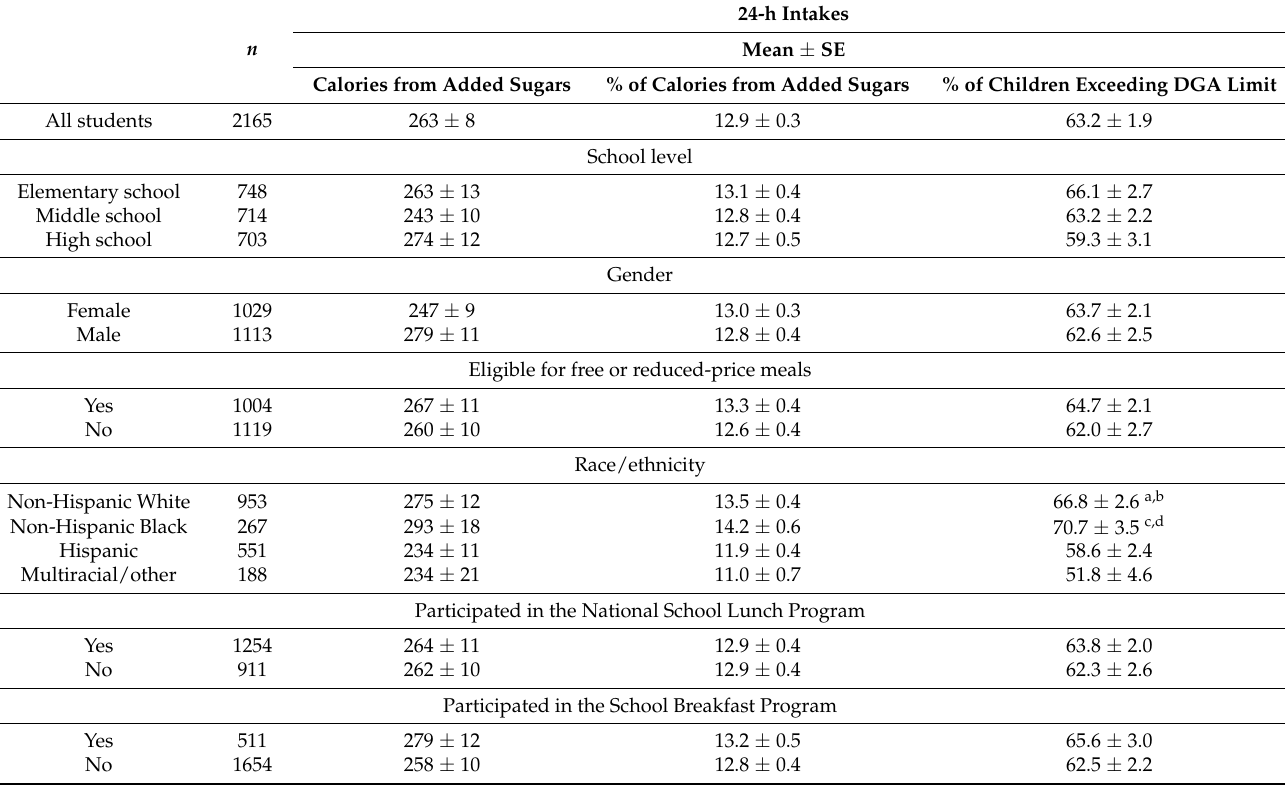
Table 5. Added sugars in 24-h dietary intakes of school-age children on school